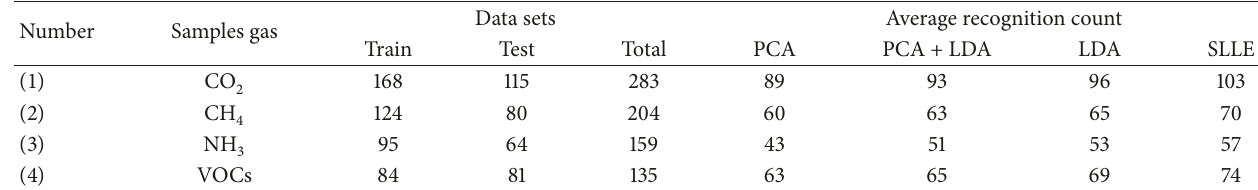
Table 3: The results of identification of the gas